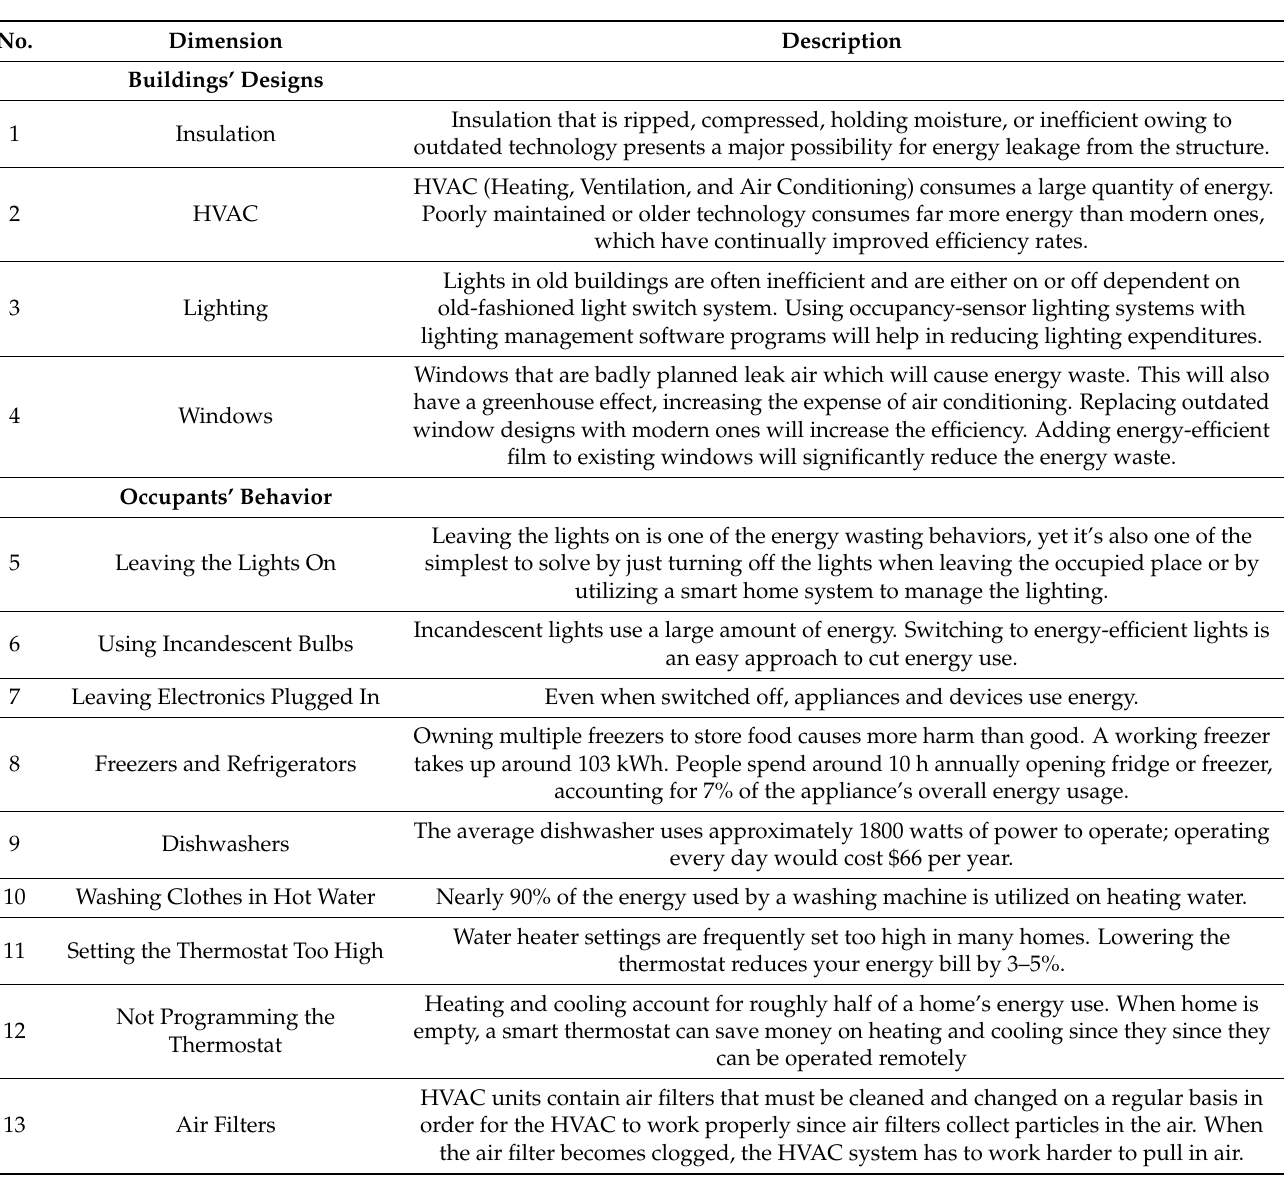
Table 1. Factors contributing to insufficient energy usage in buildings